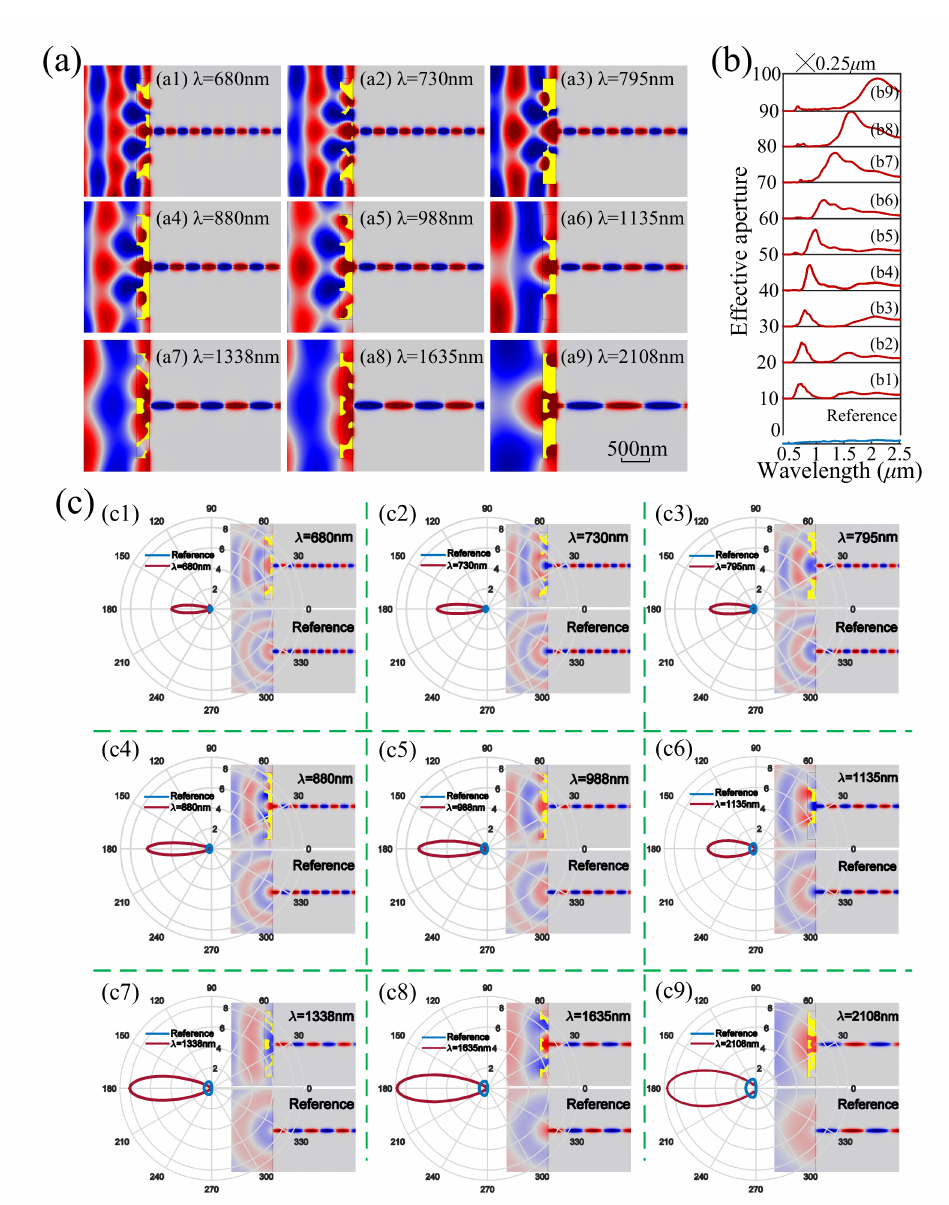
Figure A2. ( a ) Inversely designed nanoantennas. ( b ) Effective-aperture spectra for the inversely designed nanoantennas localized at the inlet of the MIM. ( c ) Emitting performance of the inversely designed nanoantennas.